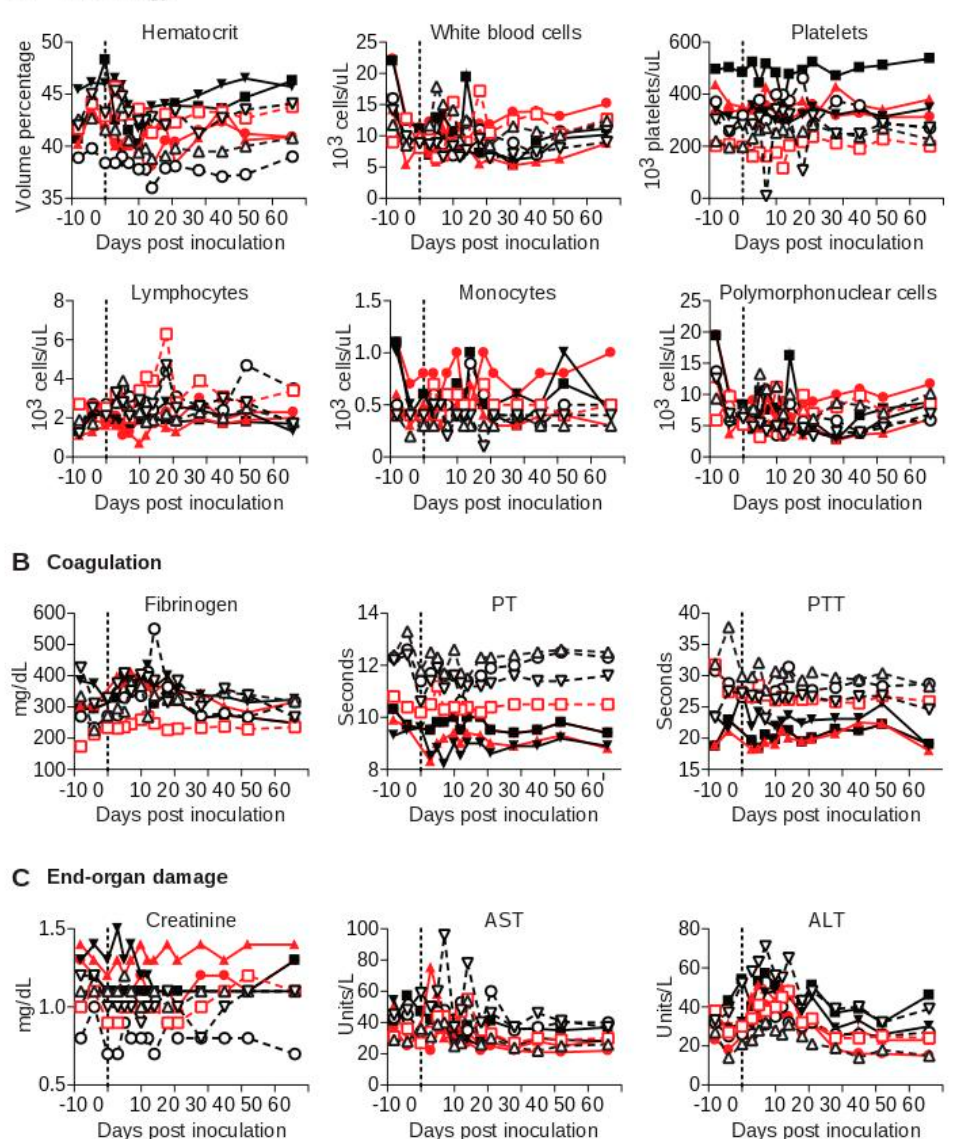
Figure 3. Laboratory evaluation of baboons and macaques inoculated with SWBV. Clinical chemistry, hematology, and coagulation studies were performed on fresh blood at the SNPRC clinical laboratory. Macaques are shown as solid symbols with solid lines, baboons are shown as open symbols with dashed lines; infected animals are shown in red and uninfected animals are shown in black.